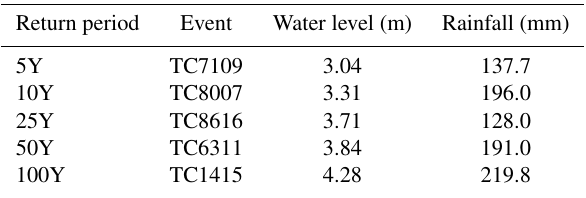
Table 2. The different return periods of TC storm tide and the re- lated TC